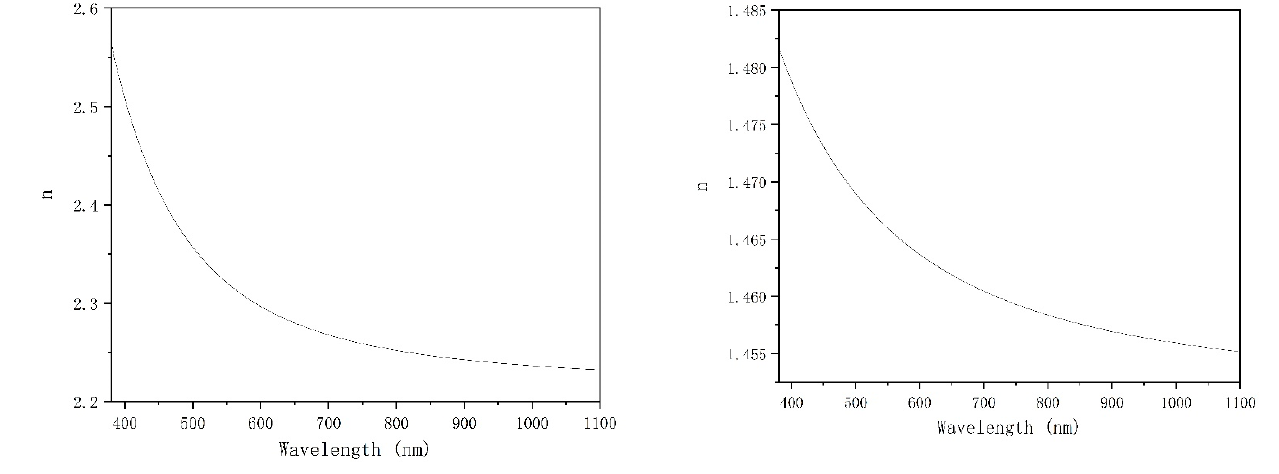
Figure 1. Refractive index of two